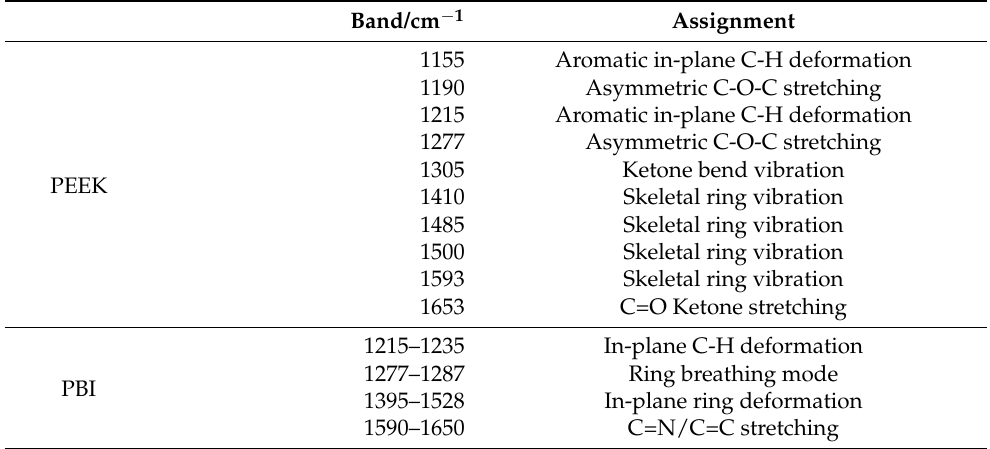
Table A1. Recorded FTIR band positions and literature assignments of bulk PEEK and PBI